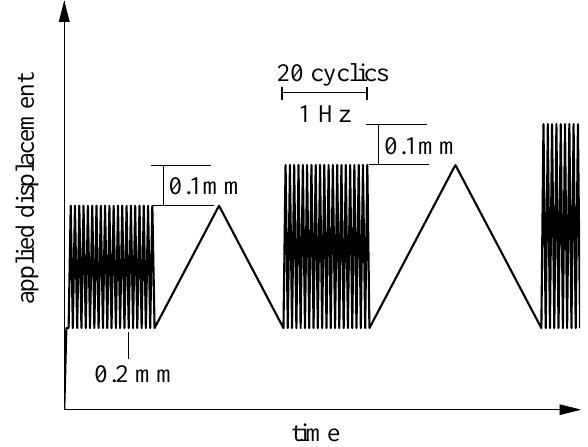
Figure 6. Loading procedure for CDS test.